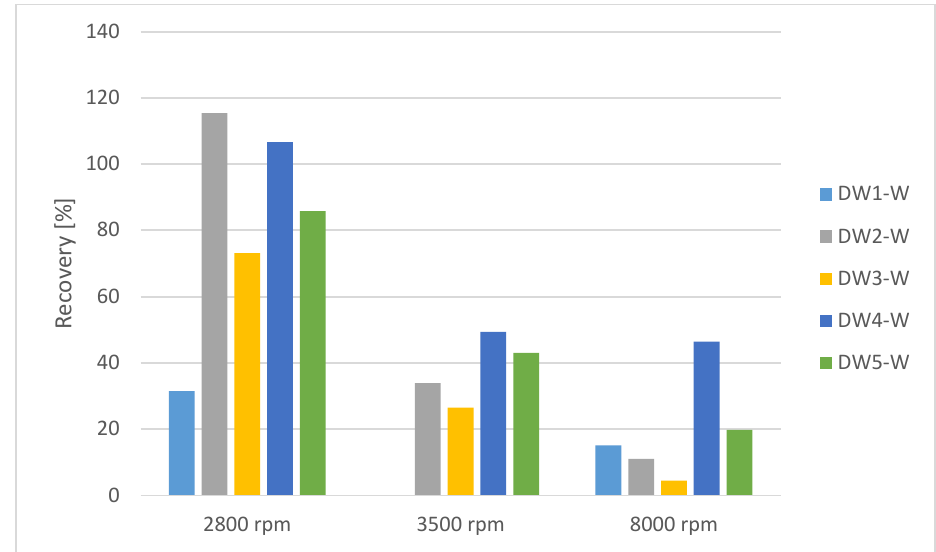
Figure 7. Recovery calculated from mass concentration for three centrifugation speeds (2800 rpm, 3500 rpm, and 8000 rpm) for DW(1–5)-W water extract samples of drilling waste with AgNPs (60 nm).